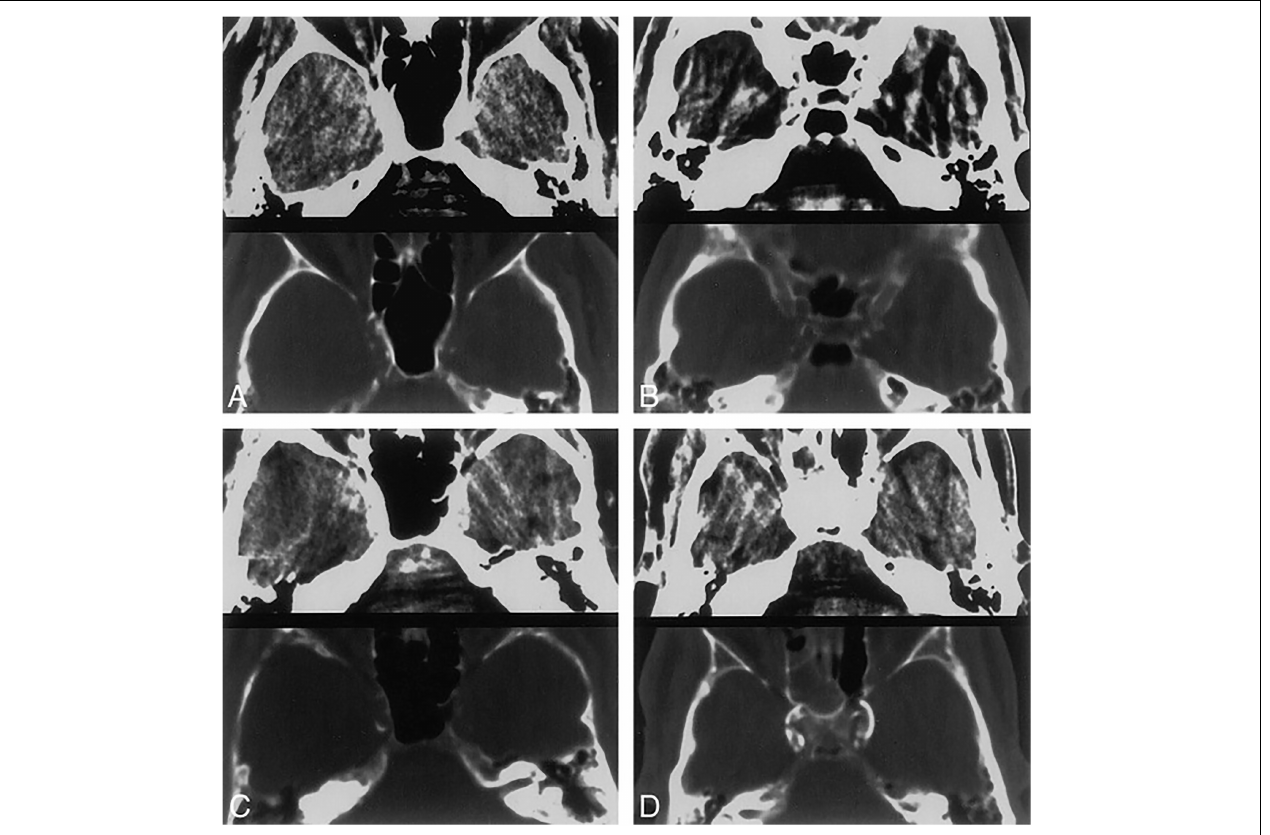
FIGURE 1 | Four different CT patterns of calcification. 5-mm-thick axial CT scans at the level of the carotid siphon. Brain (top) and bone (bottom) windows are shown in each image. (A) Thin, discontinuous calcification, bilaterally. (B) Thin, continuous calcification, right side. (C) Thick, discontinuous calcification, right side. (D) Thick, continuous calcification, bilaterally. Republished with permission of American Society of Neuroradiology, from Woodcock et al. (1999); permission conveyed through Copyright Clearance Center, Inc.